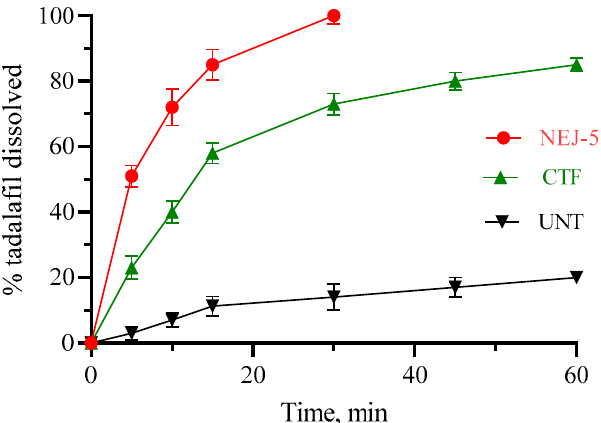
Figure 8. Dissolution of tadalafil from nano-emulsion-based jelly (NEJ-5), commercial tablet formulation (CTF) and unprocessed tadalafil powder (UNT).